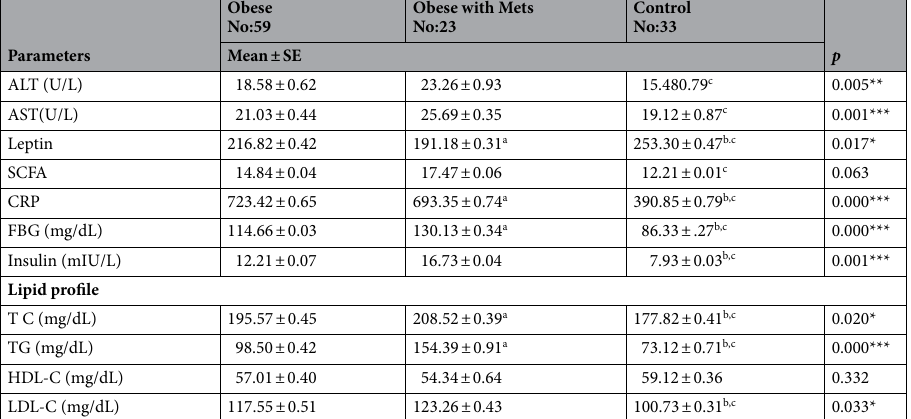
Table 2. Mean ± SE of biochemical parameters of the three studied groups. Significant between groups * p ≤ 0.05, ** p ≤ 0.01, *** p ≤ 0.001. FBG, Fasting blood glucose; TC, Total Cholesterol; TG, Triglyceride; HDL-C, High density lipoprotein –Cholesterol LDL-C, Low density lipoprotein-Cholesterol; ALT,Alanine aminotransferase ; AST, Aspartate aminotransferase; SCFA, Short chain fatty acid; CRP, C-reactive